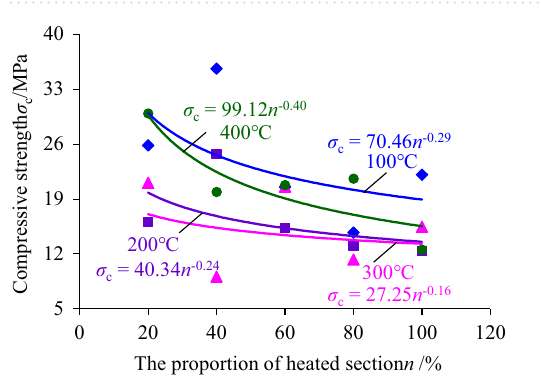
Figure 7. The change rule of compression strength with the increase of the heating segment